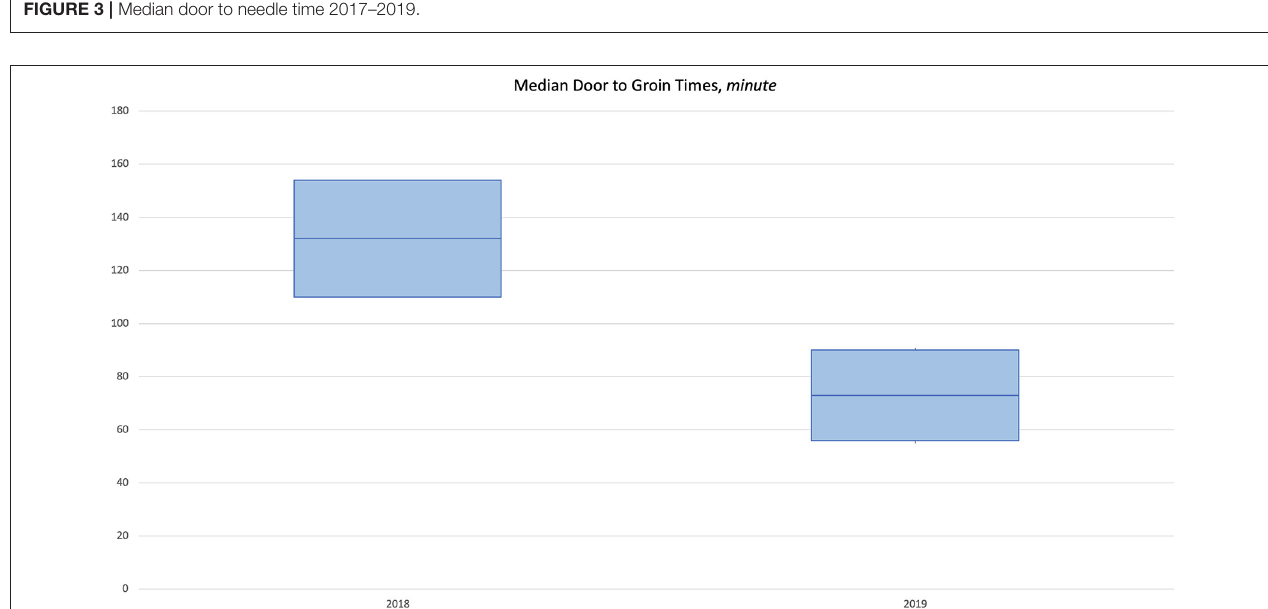
FIGURE 4 | Median door to groin puncture